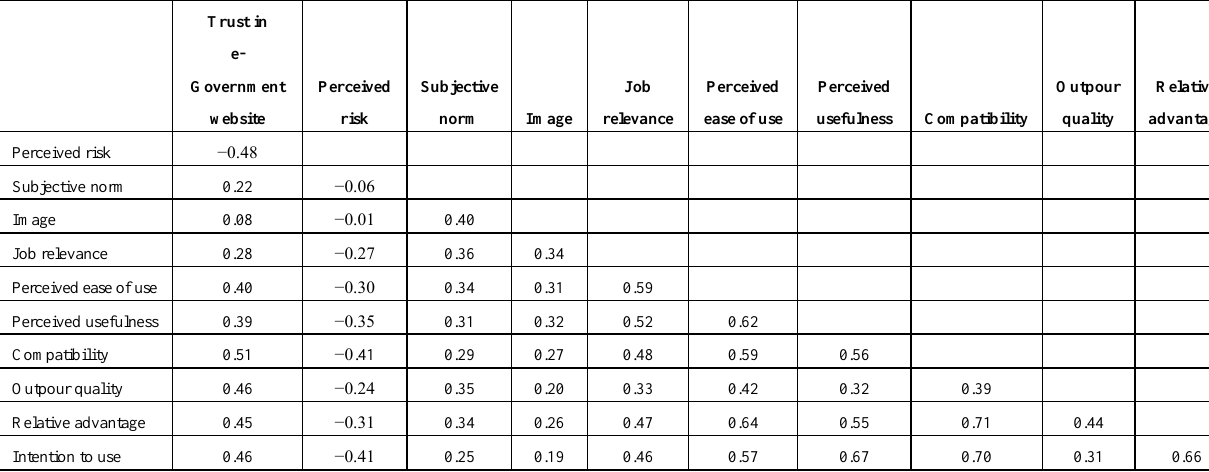
Table 3. Inter-Construct Correlations.